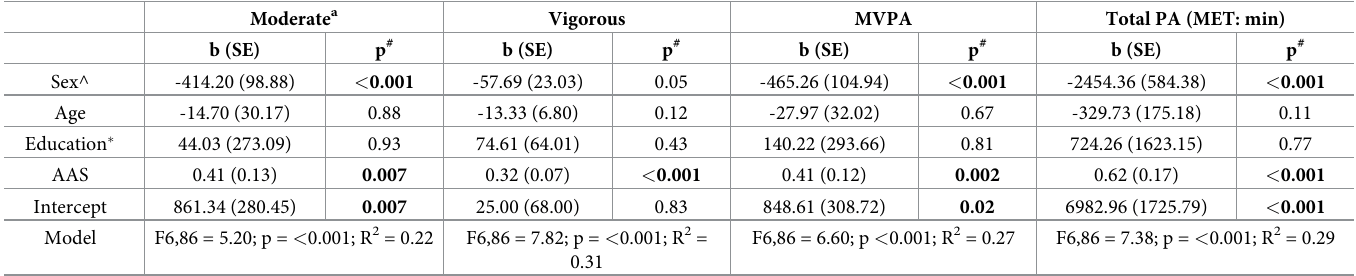
addition of chronic disease status only altered the associations for the light-intensity outcome for the PAR; there was no longer a significant absolute difference between measures (p = 0.06) (S2 Table). The addition of cohabitation did not alter the associations within any models (S3 Table). The analysis of the associations between the AAS and SWA also showed significant absolute difference between the measures at all outcomes except for vigorous-intensity. The multivari- ate models comparing the AAS to the SWA-derived variables (Table 3) showed associations for all outcomes, with adjusted R 2 values of 0.22–0.31. The addition of BMI to the models created an interaction between both the AAS and BMI (p = 0.002) and education (p = 0.005) and resulted in the association between the AAS and the SWA-derived outcomes becoming non-significant for the vigorous-intensity (S4 Table). The addition of chronic disease and cohabitation did not alter the associations within the models for any outcome (S5 and S6 Tables). Table 3. Summary of multivariate models examining the association between physical activity as measured by the AAS questionnaire and the